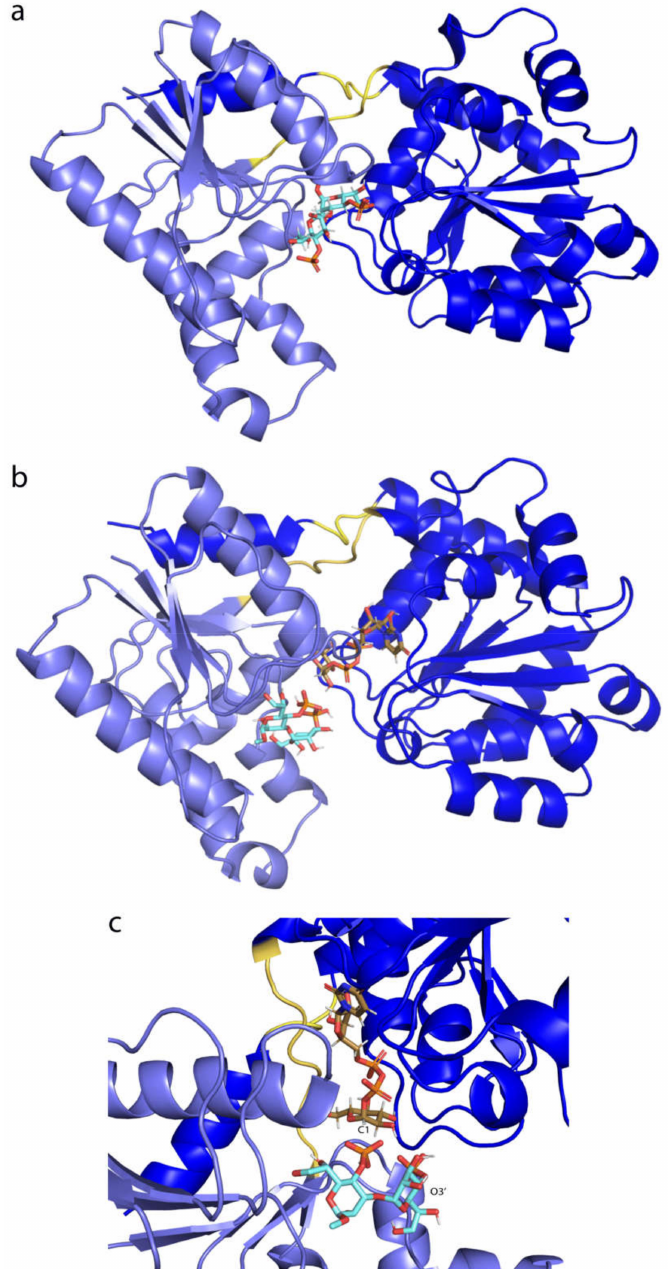
Figure 14. ( a ) Molecular dynamics representation of C4 2 − and ( b , c ) molecular docking conformation of C4 2 − with WaaG-UDP-Glc 2 −